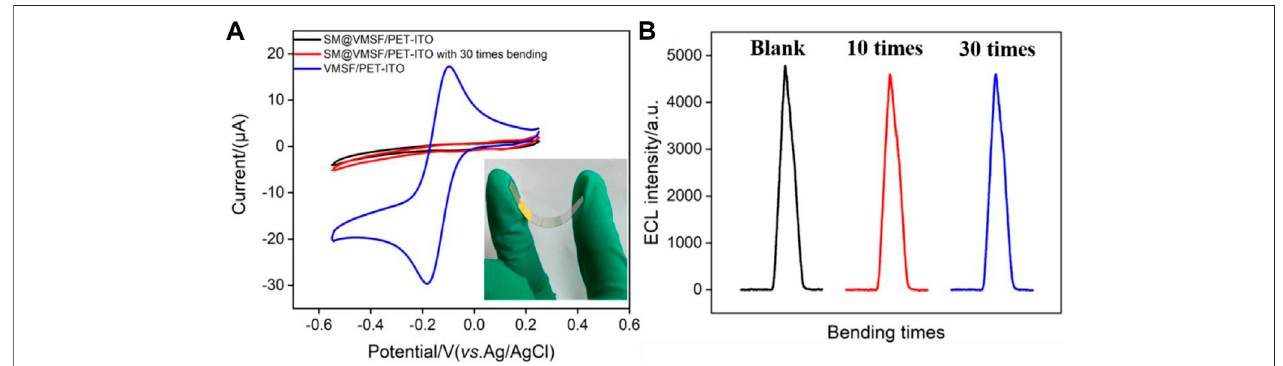
FIGURE6|(A) CVcurvesofSM@VMSF/PET-ITO andVMSF/PET-ITOelectrodesinRu (NH 3 ) 63+ solution(0.5 mmol/Lin0.05 mol/LKHP).Insetistheimageofthe electrodeincaseofbending. (B) ECLsignalsobtainedonoriginalorblendedVMSF/PET-ITOinthemixturecontainingRu(bpy) 32+ (10 μ mol/L)andclindamycin(15 μ mol/ L) in PBS solution.